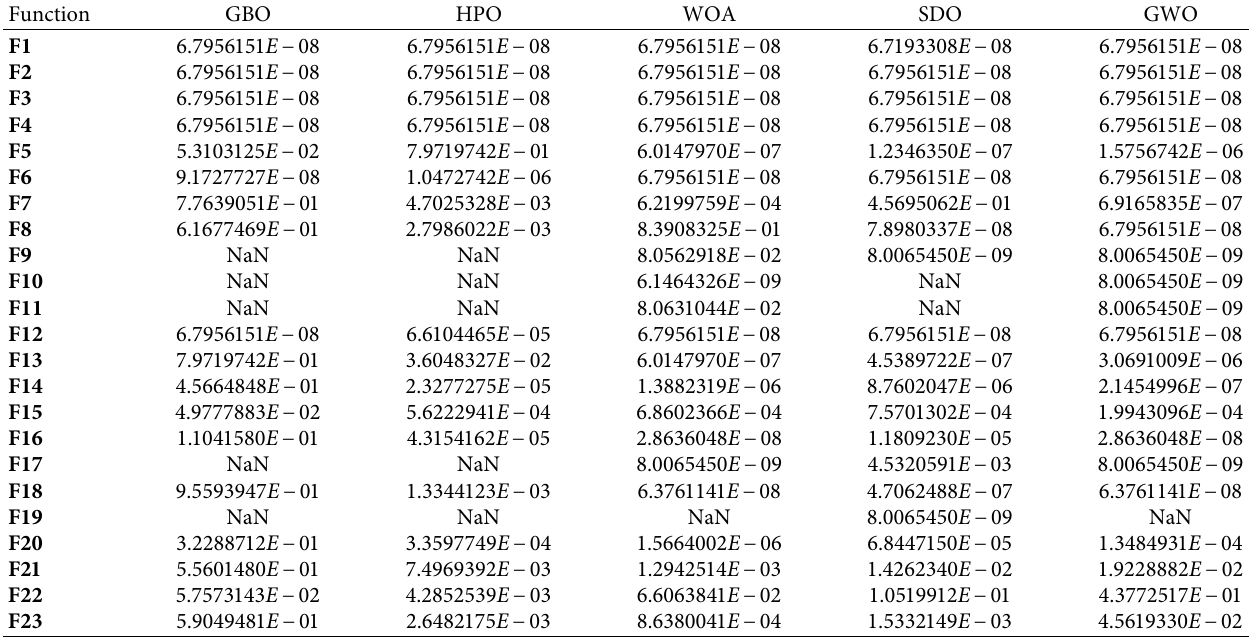
Table 4: P -values based on Wilcoxon signed-rank for IGBO algorithm versus the other algorithms.